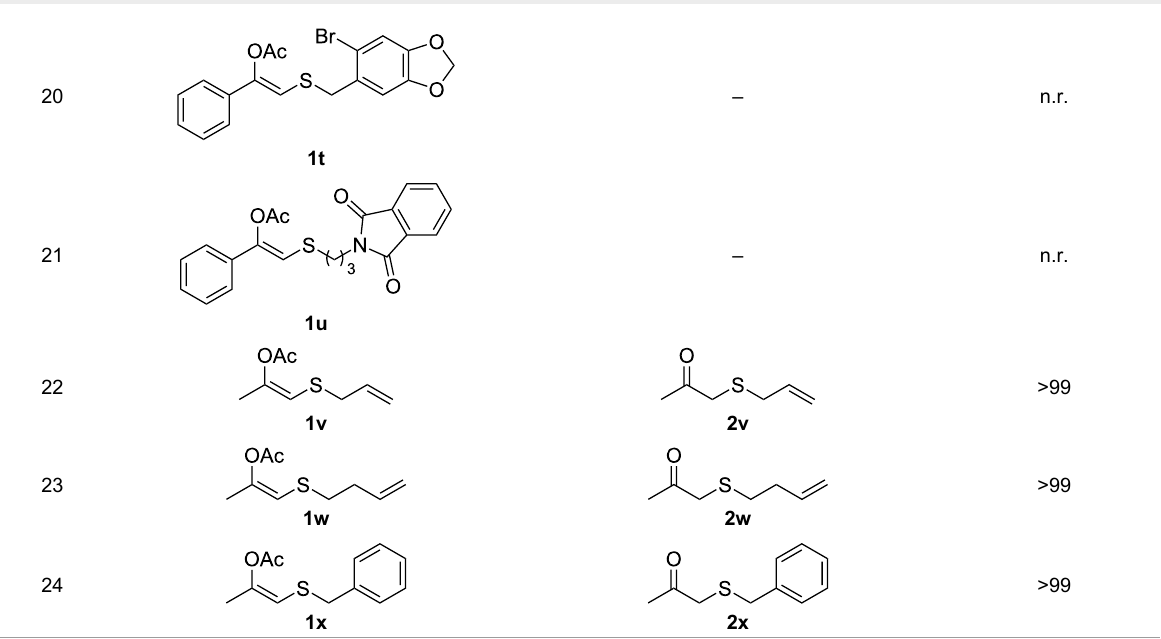
Table 2: Lipase-catalysed hydrolysis–protonation sequence over a series of β -thioalkyl enol esters. a